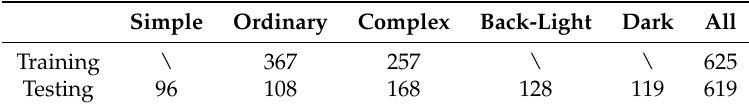
Table 1. The number of images in CUG Hand